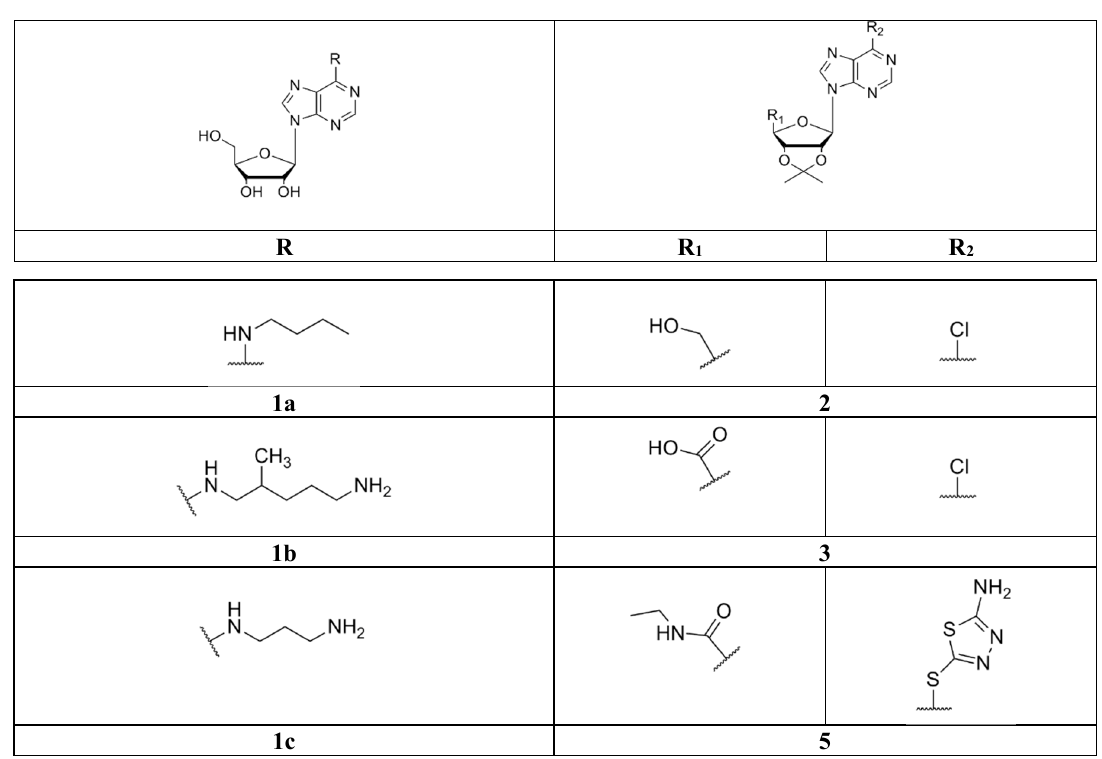
Figure 1. Chemical structures of adenosine derivatives.